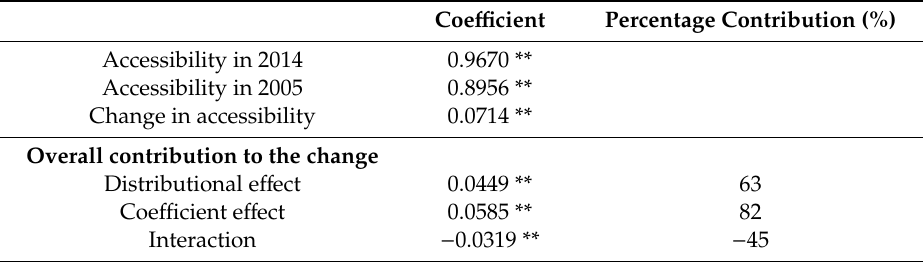
Table 2. Aggregate decomposition of the change in perceived accessibility to healthcare. Coe ffi cient